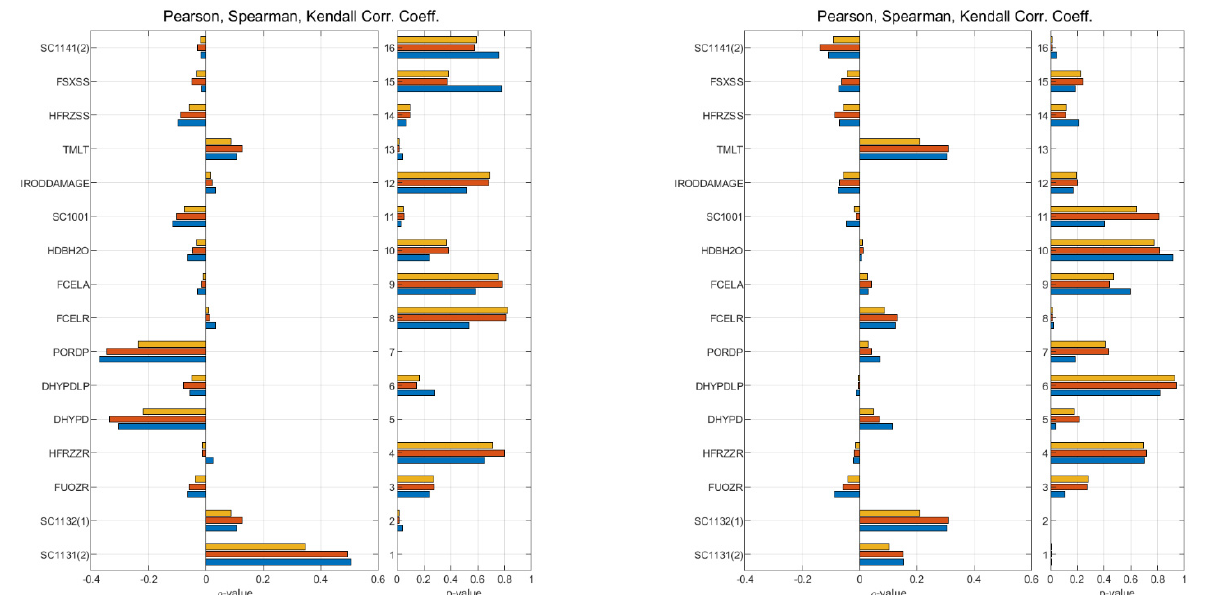
Figure 12. Pearson (yellow), Spearman (red), and Kendall (blue) correlation coefficients for PWR models; H 2 production (final core state) vs. uncertainty parameters. ( Left )—top peaked power profile, ( Right )—FPT-like power profile. Values for IRODDAMAGE and SC1001 have no meaning.